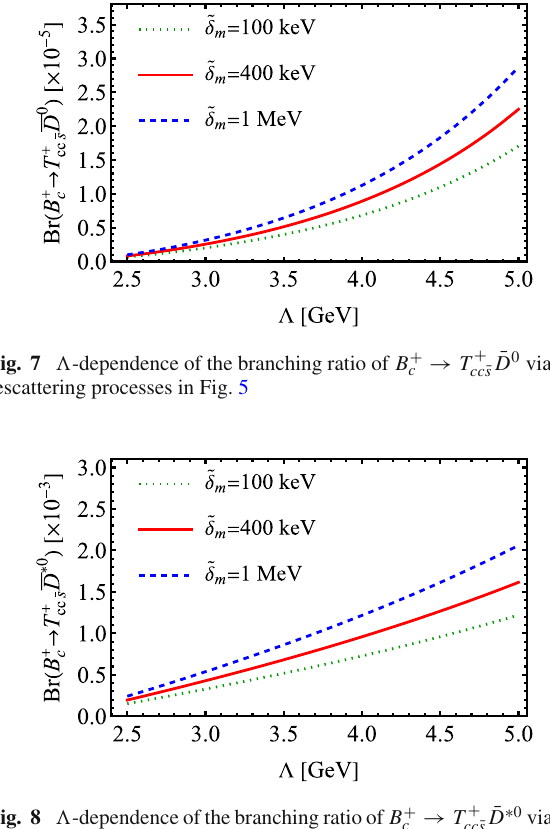
¯ D ∗ 0 Fig. 8 (cid:6) -dependence of the branching ratio of B + c → T + cc ¯ s rescattering processes in Fig.